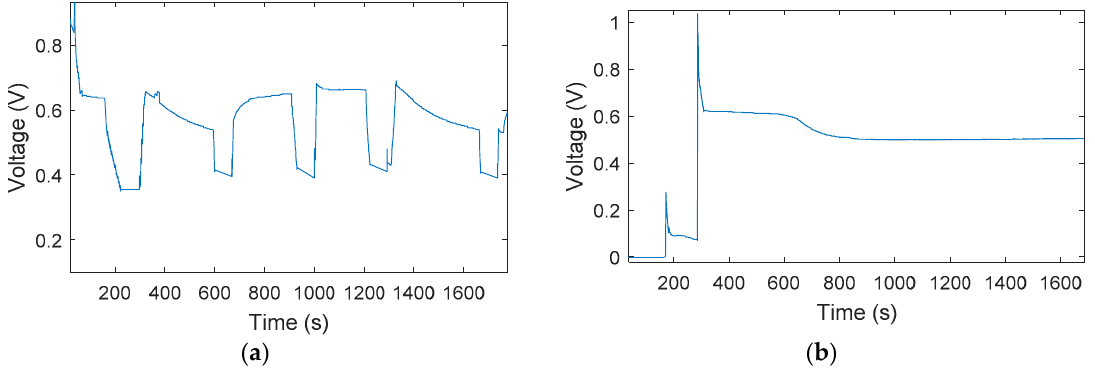
Figure 2. PEM fuel cell voltage drop due to cell flooding and membrane dehydration. ( a ) Cell flooding; ( b ) membrane dehydration.